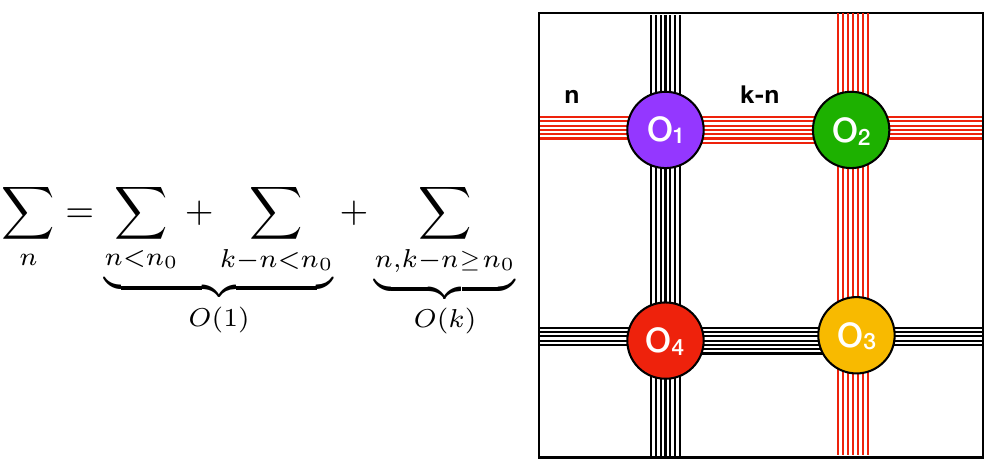
Figure 5 . Octopus principle. Con(cid:12)gurations where some available propagator bundles are not massively occupied are strongly suppressed in the large charge limit. All skeleton graphs are thus maximal graphs, where no further propagator bundle can be added without increasing the genus at